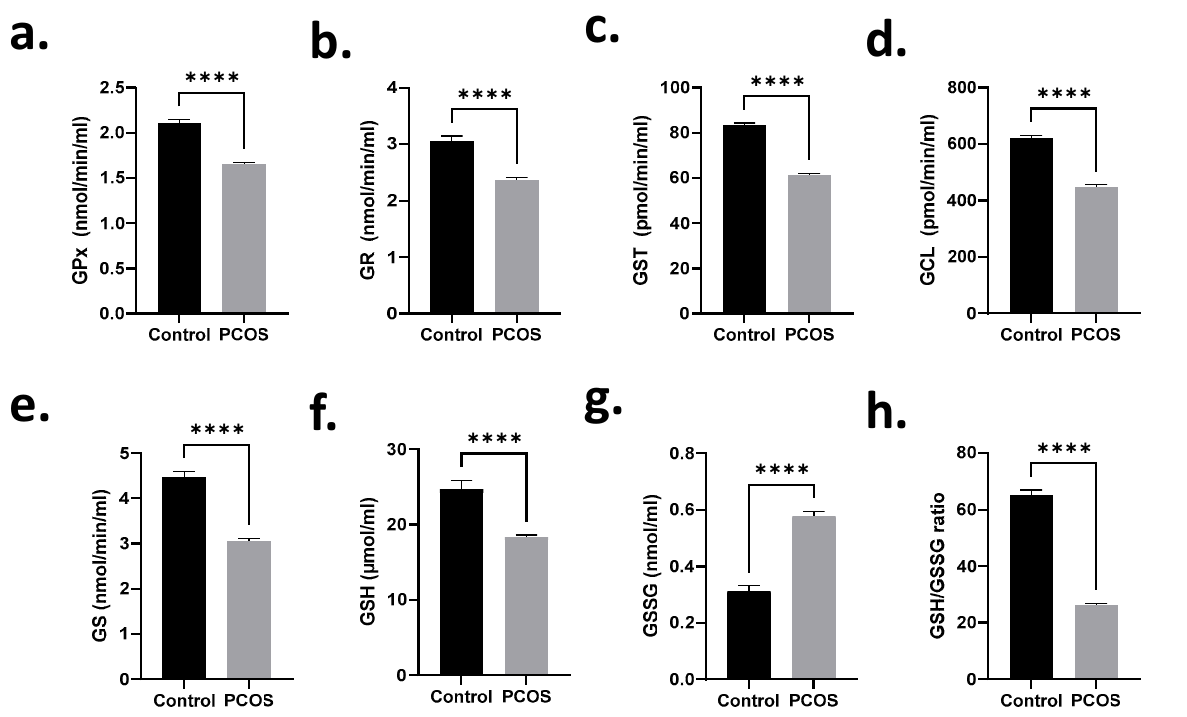
Figure 5. Glutathione homeostasis is disrupted in PCOS patients. Means + SEM of ( a ) GPx, ( b ) GR, ( c ) GST, ( d ) GCL, and ( e ) GS serum enzyme activities, levels of ( f ) GSH and ( g ) GSSG, and ( h ) GSH/GSSG ratio. **** p < 0.0001.